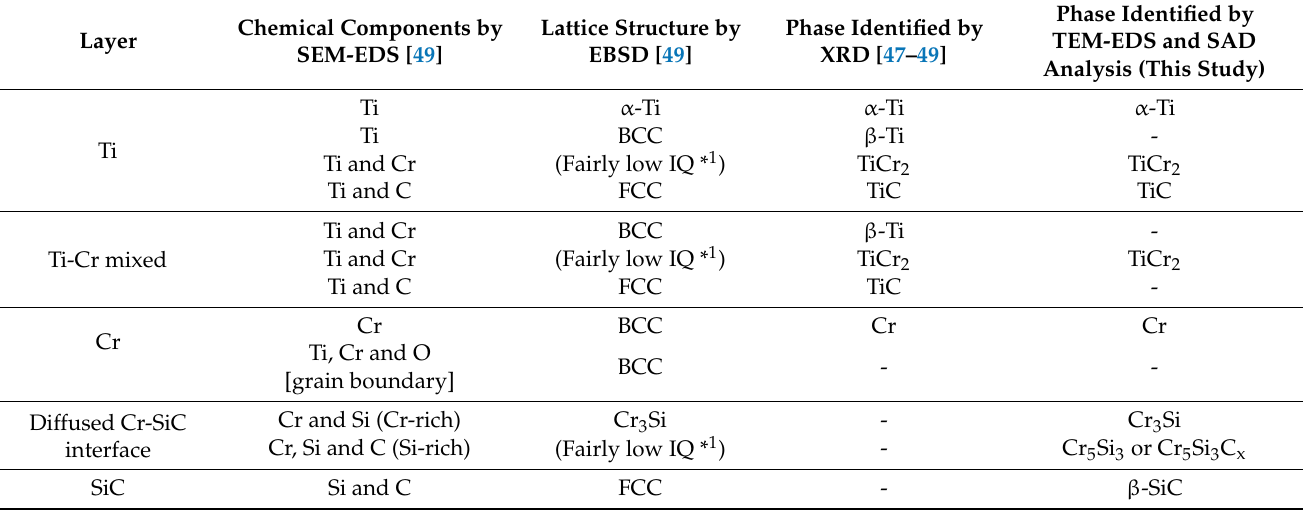
Table 2. Identification of phases in Ti-Cr multilayer coating heat-treated at 1223 K for 1.8 × 10 3